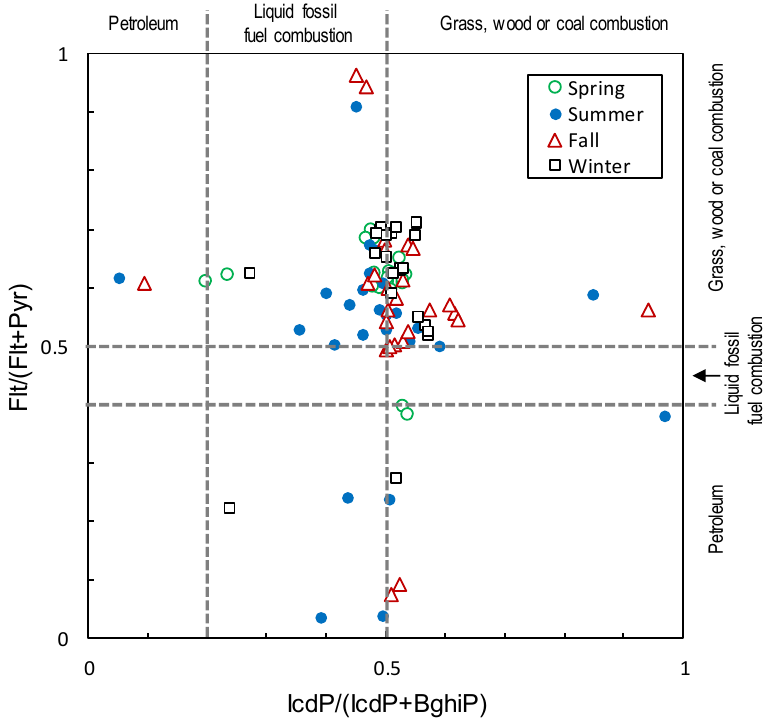
Figure 4. Cross plot of the diagnostic ratios of the forest site for PAH sources in each season.